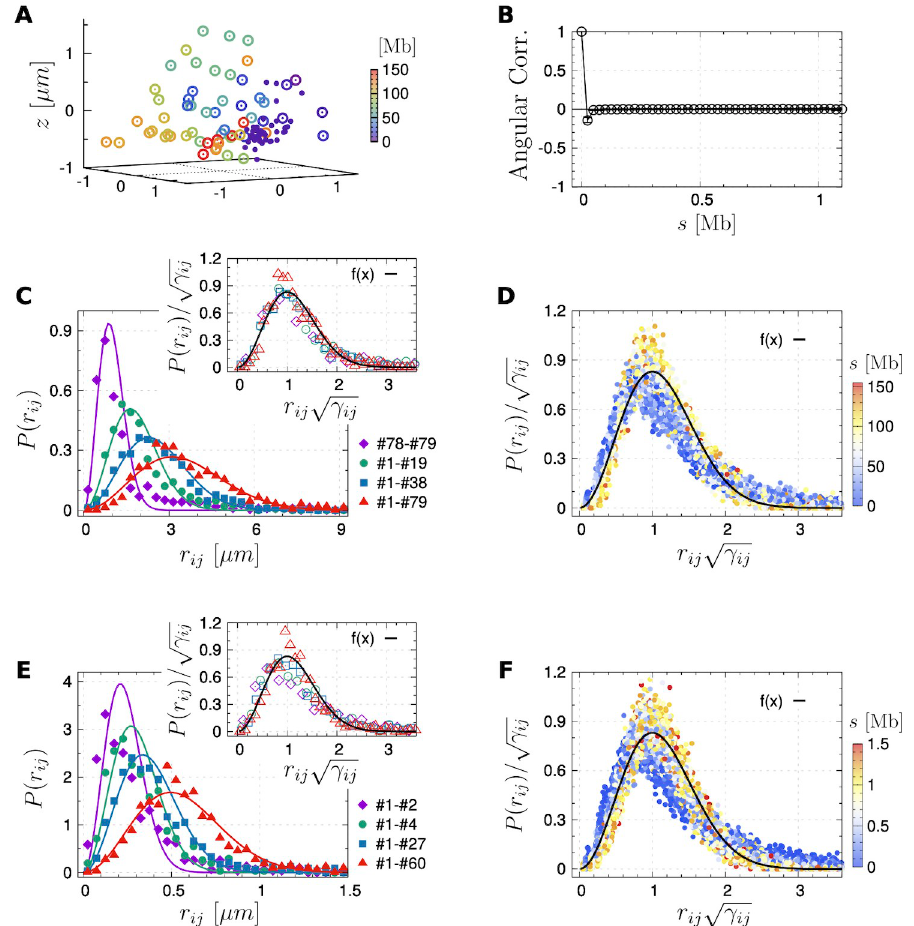
Fig 1. Chain organization of chr3 of mouse ES cells measured in the DNA seqFISH+ experiment [24]. (A) 3D positions of 151 imaged loci spaced about 1 Mb apart (large empty dots) and 60 consecutive loci with an equal space of 25 kb (small solid dots) in one of 446 sample cells. (B) Angular correlation of the chromatin segments at 25 kb resolution. (C) Distribution of the physical distance of four loci pairs at 1 Mb resolution (markers) with their fittings to our theory (lines, Eq 3), which are rescaled by using the fitting parameter ( γ ) and plotted in the inset. (D) Rescaled ij pairwise distance distributions of all loci pairs, which are colored by their genomic lengths. (E, F) Similar as (C, D) but at 25 kb